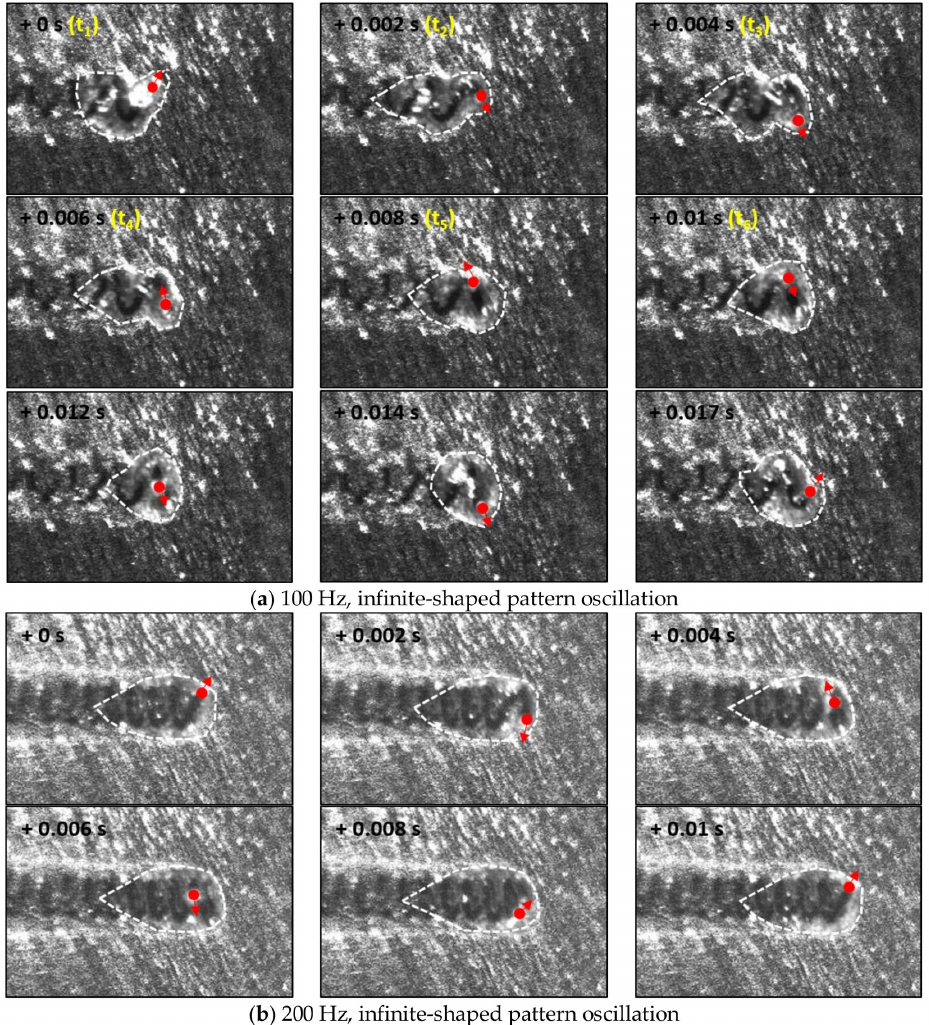
Figure 9. High-speed camera images of the molten pool under laser beam oscillation with an infinite-shaped pattern during a single oscillation. The oscillating laser beam welding was performed with 900 W laser power at 3.5 m/min. The oscillation width was fixed at 0.8 mm, while the frequency varied: ( a ) 100 and ( b ) 200